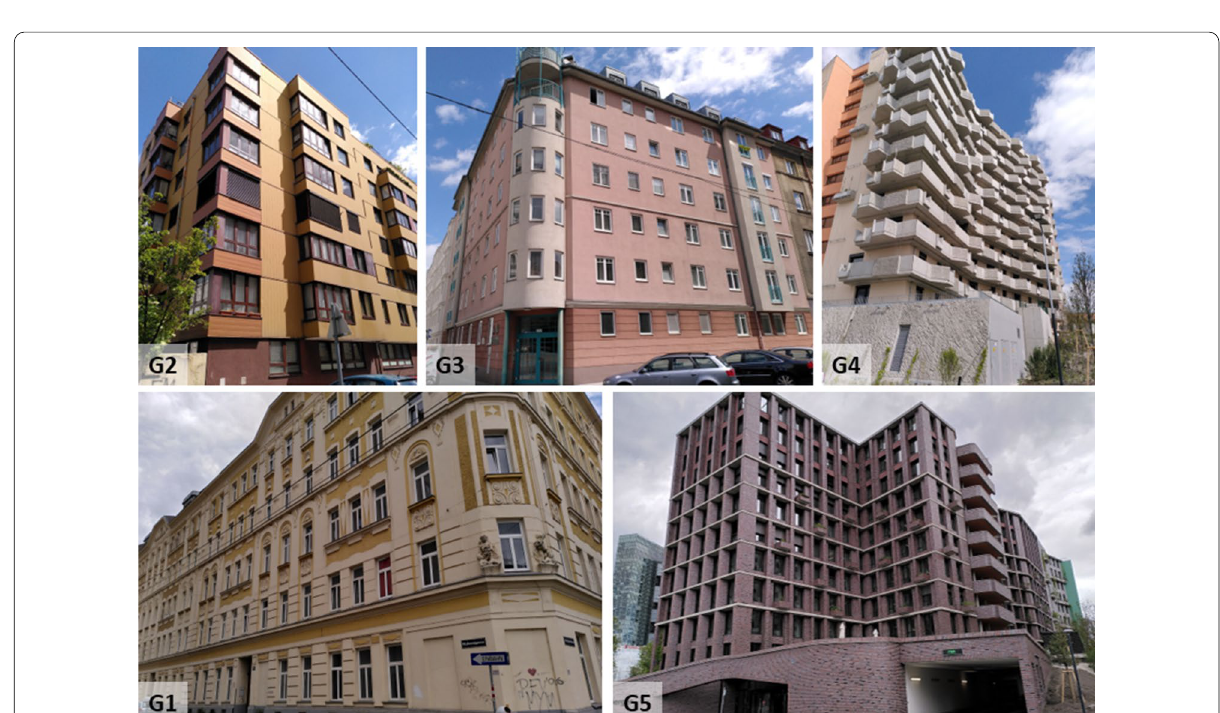
Fig. 2 Typical Viennese building types for the implementation in uhiSolver: G1 1970s, G3 hollow brick building of the 1970s, G4 =